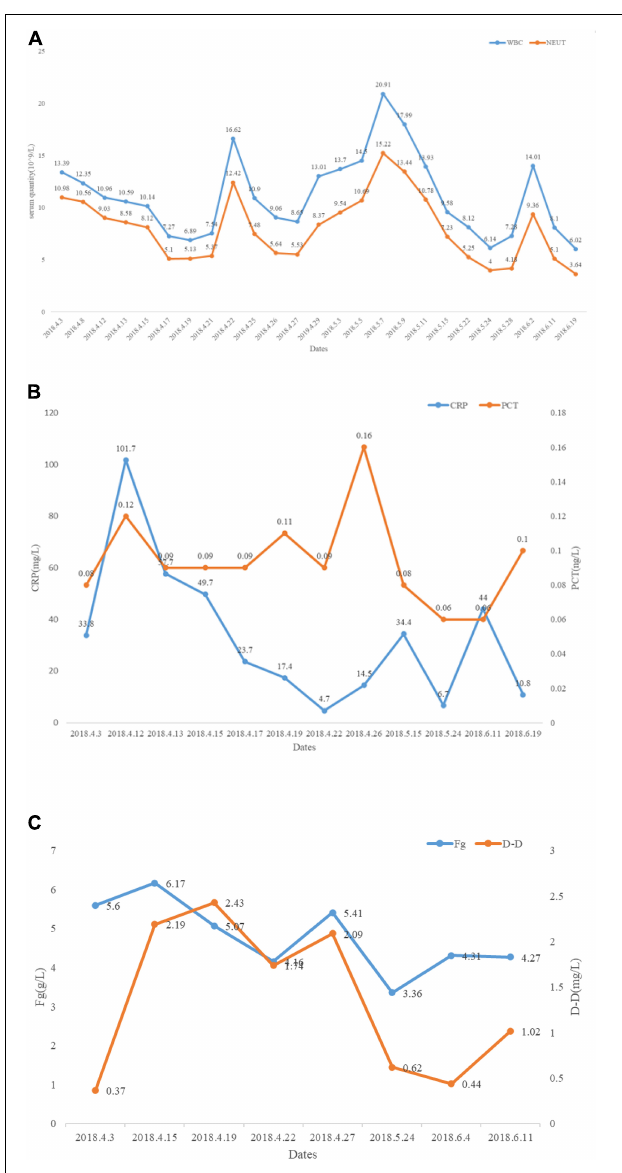
FIGURE 3 | Changes in laboratory study results after taking Piperacillin-Tazobactam, Meropenem, Linezolid, TMP-SMX, etc. (A) White blood cell (WBC) and neutrophils (NE) reduced significantly after taking Piperacillin-Tazobactam, Meropenem, Linezolid, TMP-SMX, etc. (B) C-reactive protein (CRP) and procalcitonin (PCT) reduced significantly after taking Piperacillin-Tazobactam, Meropenem, Linezolid, TMP-SMX, etc. (C) Changes in coagulation indicators during